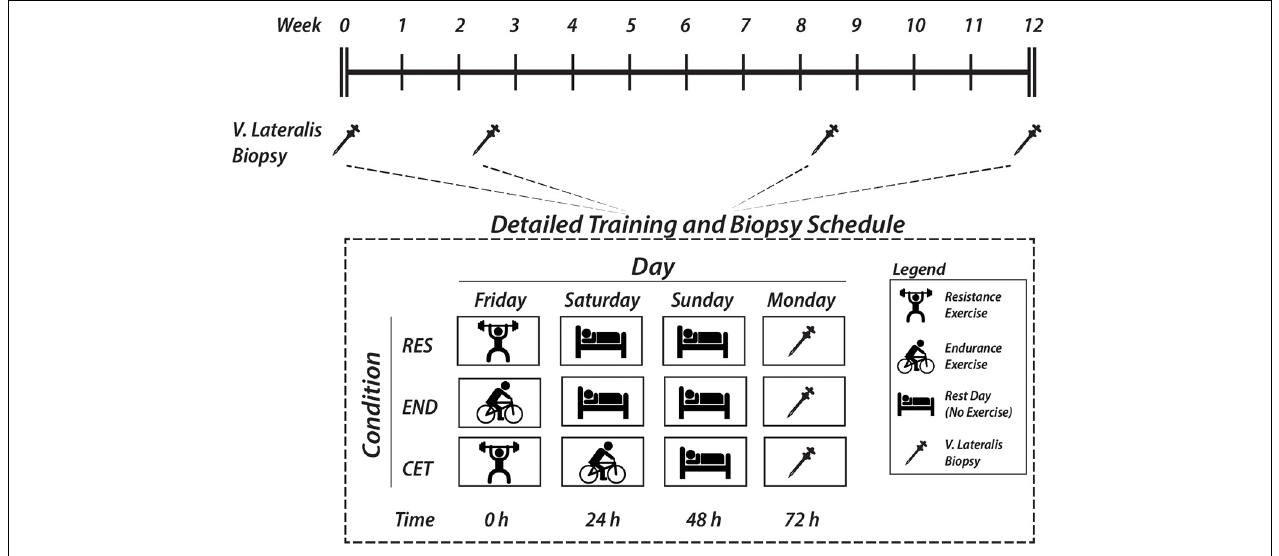
FIGURE 1 | Schematic overview of study timeline and detailed vastus lateralis muscle biopsy sampling times following endurance (END), resistance (RES), or concurrent (CET) training.